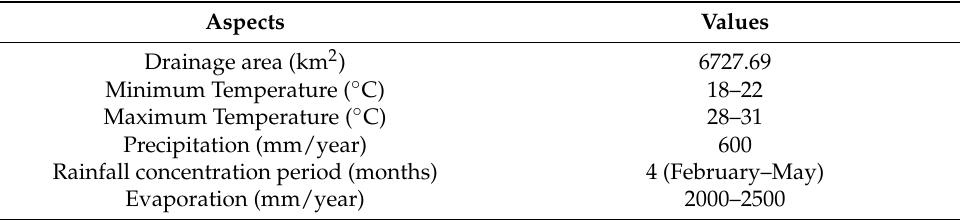
Table 1. Hydroclimatic aspects of the Paraiba River